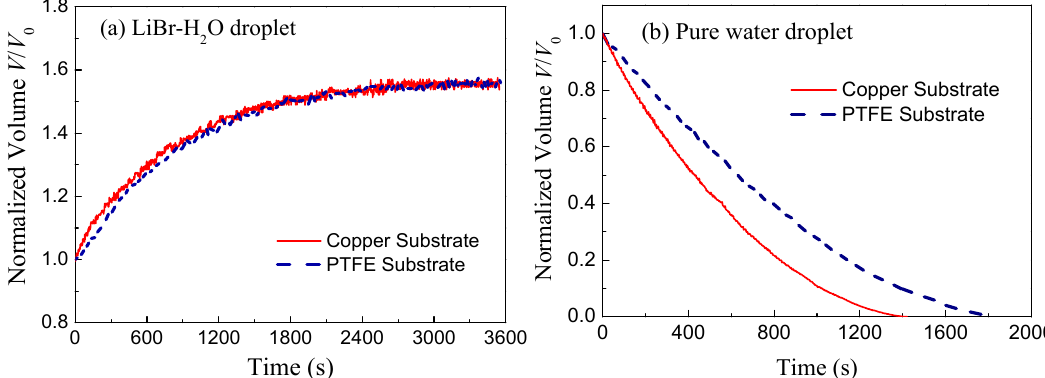
Figure 3. Evolution of normalized volume for ( a ) LiBr-H 2 O droplets and ( b ) pure water droplets on copper (solid red lines) and PTFE (dashed blue lines) substrates coated with FEP along with time for 25 °C and 60% RH conditions.